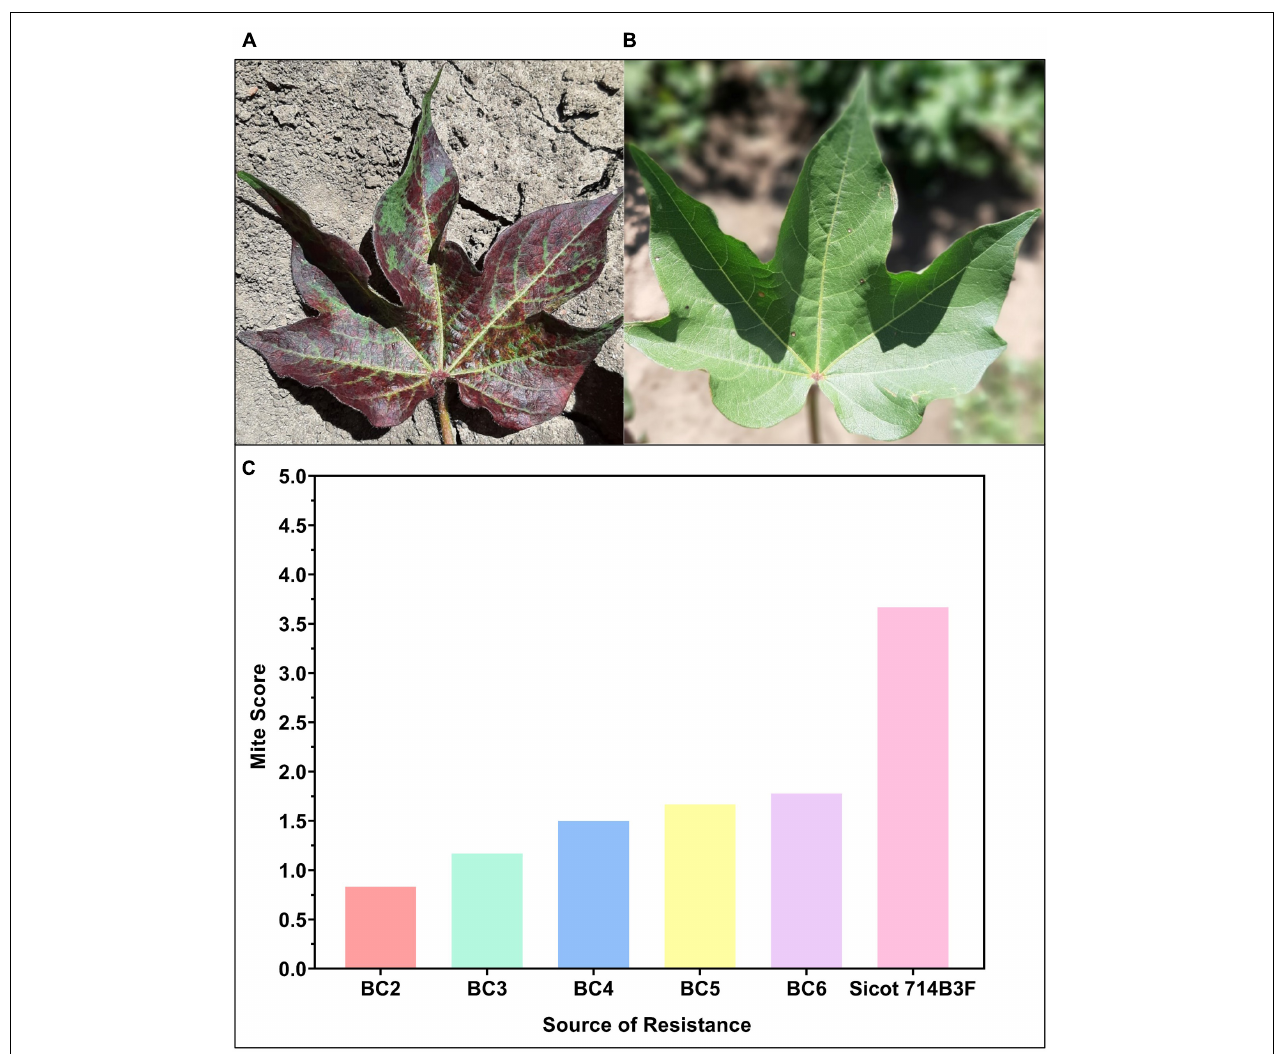
FIGURE 6 | (A) Susceptible (Sicot 714B3F recurrent parent) and (B) resistant two-spotted spider mite cotton germplasm from the CSIRO cotton breeding program (Photos: Lucy Egan). (C) Progress of breeding mite resistant germplasm showing that as backcross (BC) generation number increases mite resistance scores have remained lower than the susceptible recurrent parent, Sicot 714B3F, and relatively stable. Data from C. Trapero, used with